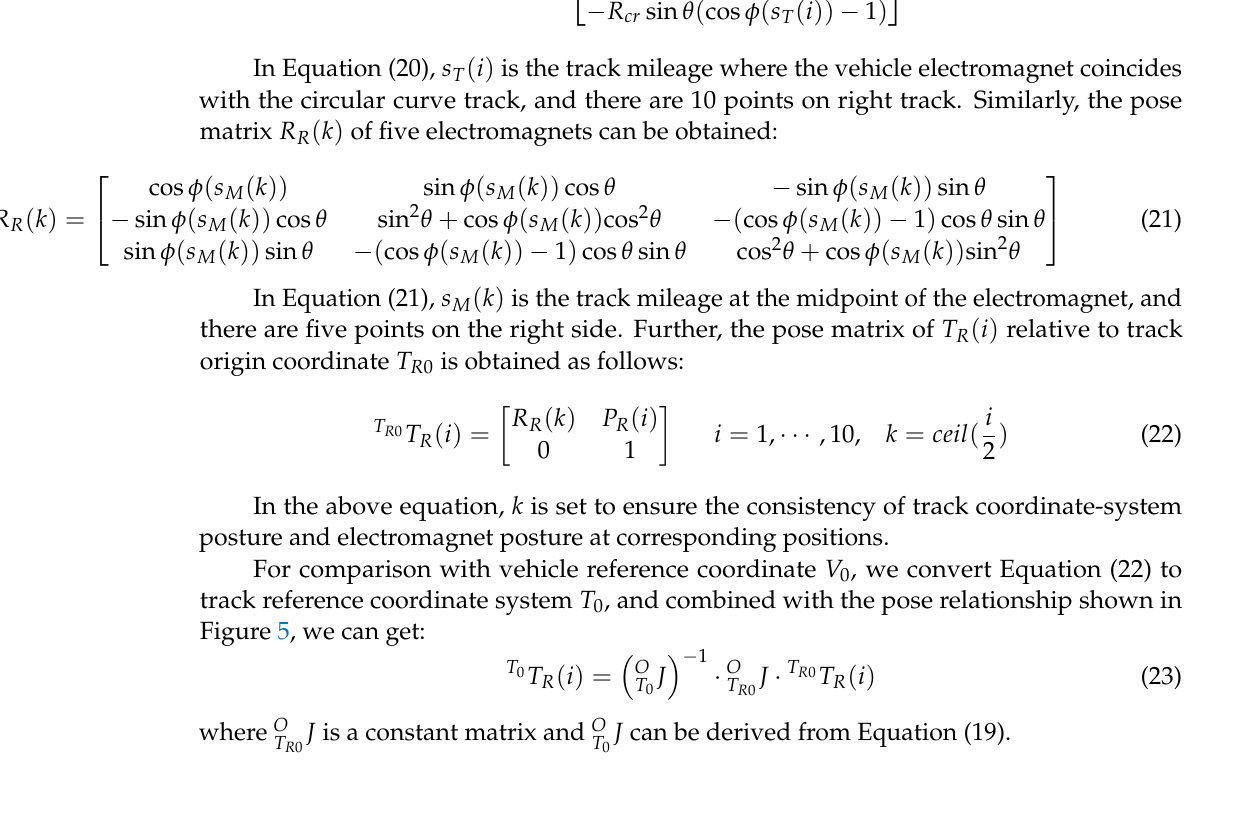
Figure 6. Relationship between track and vehicle coordinates on circular curve. Putting T R ( 1 ) at the position of T R 0 . According to the relationship between mileage and rotation angle, the position vector P R ( i ) of T R ( i ) can be obtained from Equation (19):